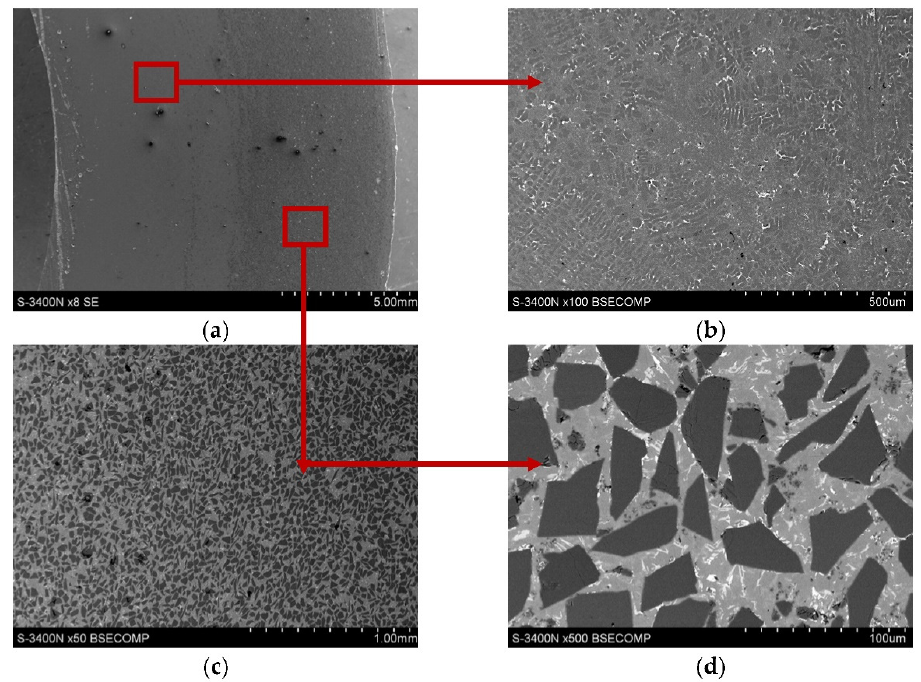
Figure 5. Cross-section perpendicular to the rotational axis of centrifugal cast obtained with AlSi12CuNiMg2/SiC p 10 wt% composite suspension; the red arrows indicates the microstructure of the Al/SiC p composite layer: ( a ) macrostructure with visible outer composite layer, SEM; ( b ) microstructure of modified Al matrix alloy (area without SiC p ), SEM; and ( c , d ) microstructure of SiCp particle-rich region,